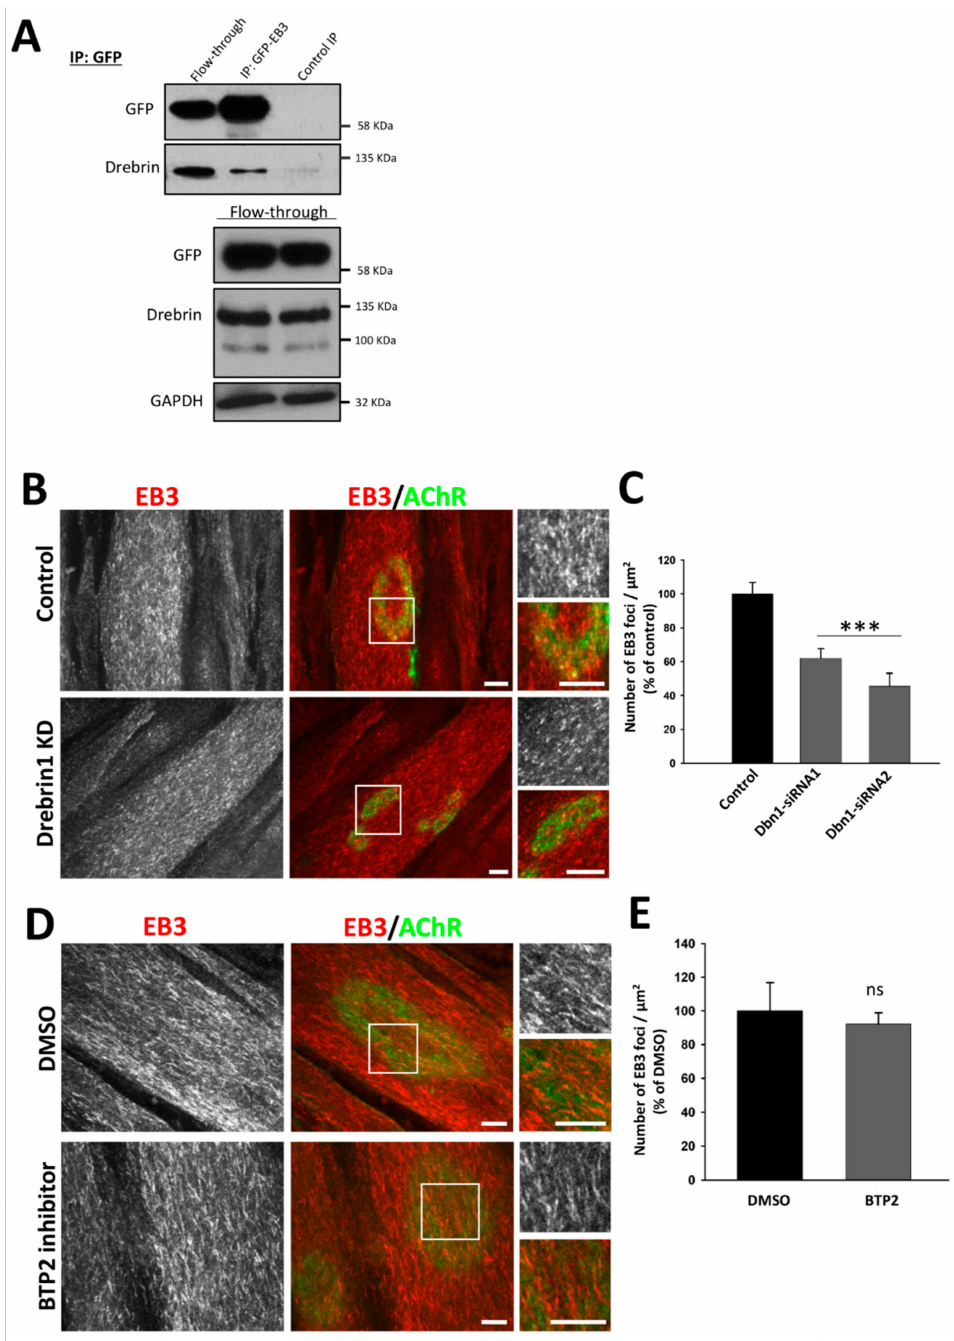
Figure 5. Drebrin and microtubule-associated EB3 interact in myotubes and drebrin knockdown impacts microtubule capture at AChR clusters. ( A ) Co-immunoprecipitation of endogenous drebrin with overexpressed EB3-GFP in homogenates from C2C12 myotubes cultured on laminin-111. Flow-through—lysate incubated with the beads, IP—eluate from the beads coated with anti-GFP antibody, Control IP—eluate from the uncoated beads. ( B ) Control and drebrin-depleted C2C12 myotubes labeled for AChRs (green) and microtubules plus-end protein EB3 (red). Representative images from control and drebrin knockdown with siRNA1 are shown. Control myotubes were transfected with non-targeting siRNA. Scale bars—10 µ m. ( C ) Quantification of EB3 foci localized underneath AChR clusters after drebrin knockdown. ( D ) EB3 foci under AChR clusters in control and BTP2-treated C2C12 myotubes labeled for microtubules plus-end protein EB3 (red) and AChRs (green). Scale bars—10 µ m. ( E ) Number of EB3 foci localized underneath AChR clusters upon BTP2 treatment. Data are presented as a percentage of control (myotubes transfected with non-targeting siRNA or myotubes incubated with DMSO (vehicle)). Error bars represent SEM. Student’s T -test, p ≤ 0.001 (***); ns—not